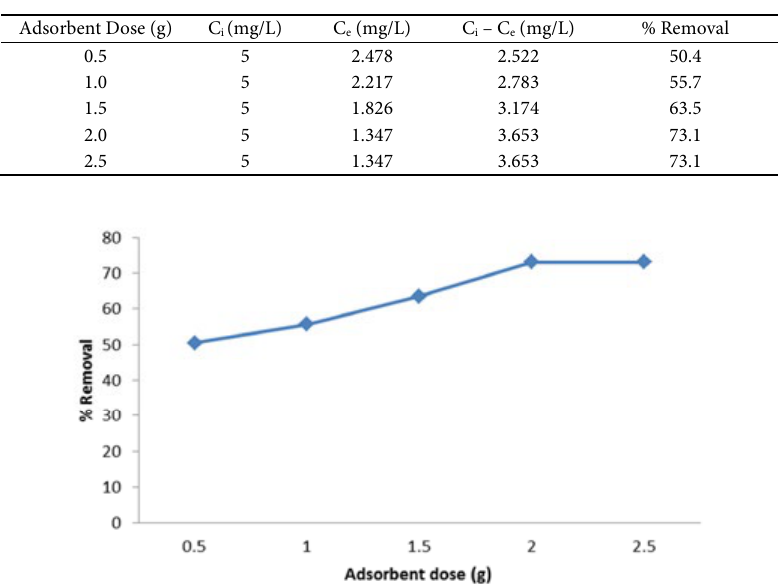
Fig. 2. Effect of adsorbent dose graph for fluoride at adsorbate concentration of 5 mg/L, contact time of 50 (minute), temperature of 25 o C, and various adsorbent dosages of 0.5, 1.0, 1.5, 2.0 and 2.5 g